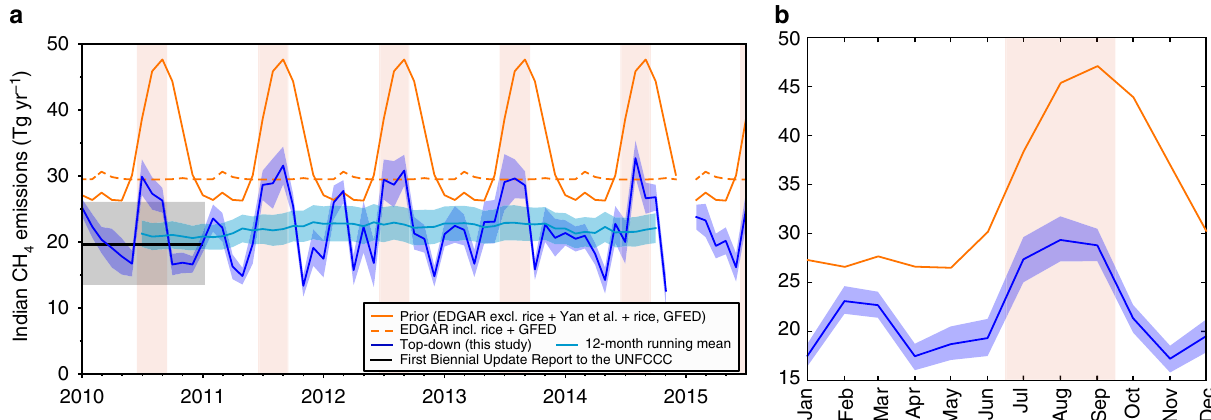
Fig. 1 Comparison of India ’ s top-down CH 4 emissions and seasonal cycle with bottom-up inventories. a Indian CH 4 emissions (as Tg yr − 1 ) for the prior inventories (orange, solid line) and for the top-down estimated here (dark blue line). The prior was comprised by EDGAR 2010 (excluding rice), Yan et al. 17 rice and GFED v3.1 18 biomass burning. For comparison, the dashed orange line corresponds to EDGAR 2010 (including rice) and GFED. The turquoise line and shading indicates a 12-month running mean of the top-down emissions (uncertainties assuming full correlation between months). The black line and grey shading correspond to 2010 emissions submitted to the UNFCCC (BUR) and uncertainties (based on percentage uncertainties for the year 2000, the last year for which uncertainties were published: 50% enteric fermentation, 8% rice, 125% fossil fuel, 150% waste 23 ). b Average prior (orange) and top- down (blue) seasonal cycle. In all panels, shading corresponds to 5th – 95th percentile uncertainties. The monsoon season is highlighted in pink